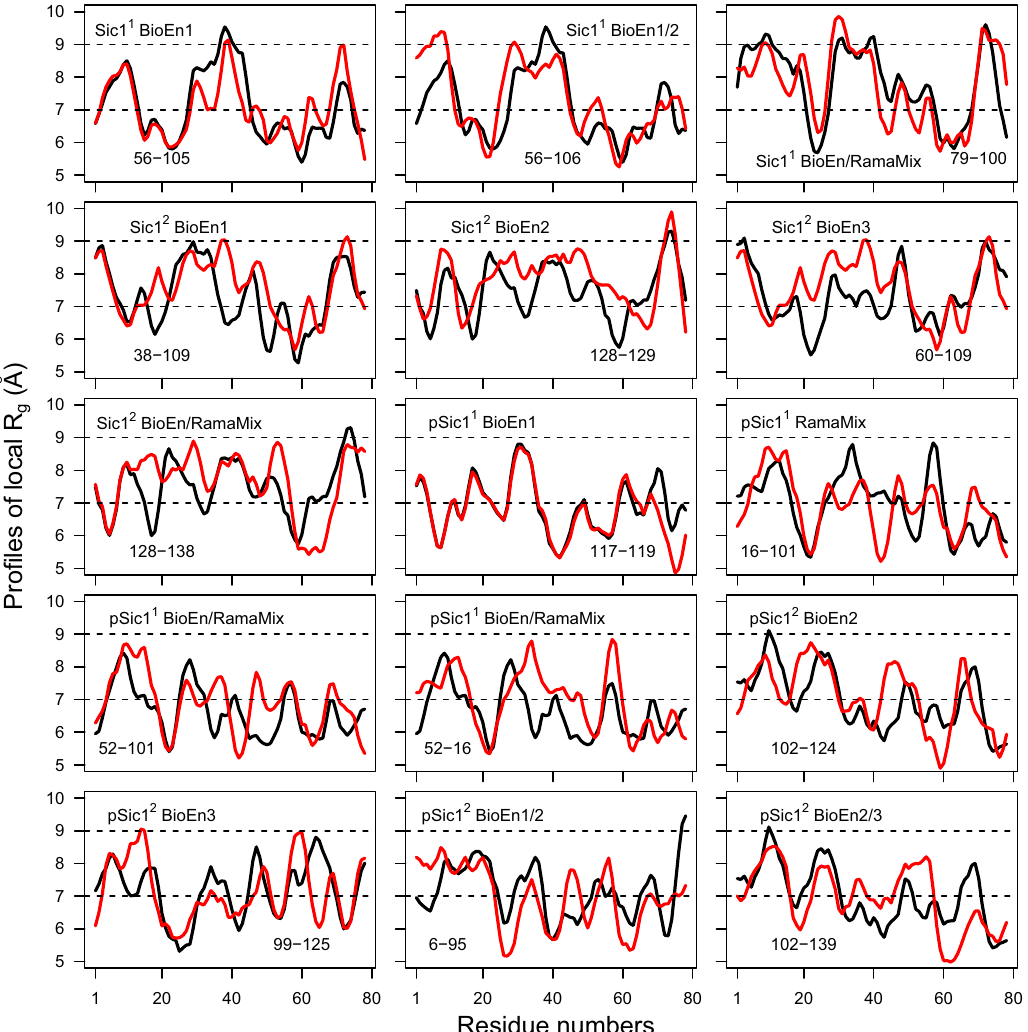
Figure 5. Superposition of profiles P q (Eq. 1) displaying distances smaller than 8 Å extracted from Figs. 4 and 1 2 1 2 S8, S9. The name of the run (Sic1 , Sic1 , pSic1 , pSic1 ) is given, along with the name of the considered fits (BioEn1, BioEn2, BioEn3, RamaMix, RamaMix/BioEn) and the conformations numbers. The labels RamaMix/ BioEn correspond to the comparison of conformations selected by BioEn on one side and RamaMix on the other side. The labels BioEn1/2 and BioEn2/3 correspond to the comparison of conformations selected by BioEn from two different SAXS